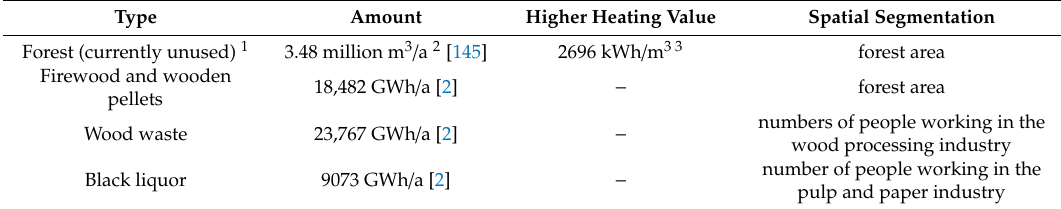
Table 6. Considered wood, wood products, wood waste, and black liquor.